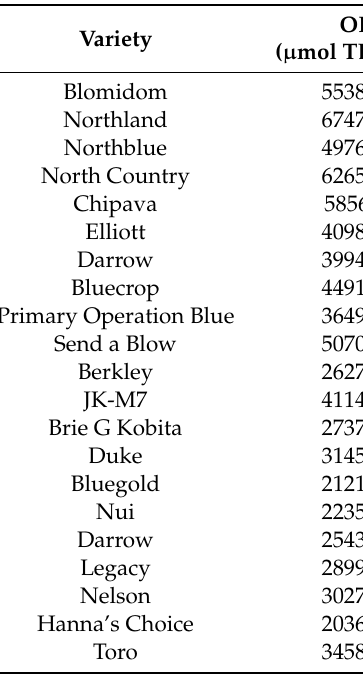
Table 2. Antioxidant activity of di ff erent blueberry extracts ( V. corymbosum